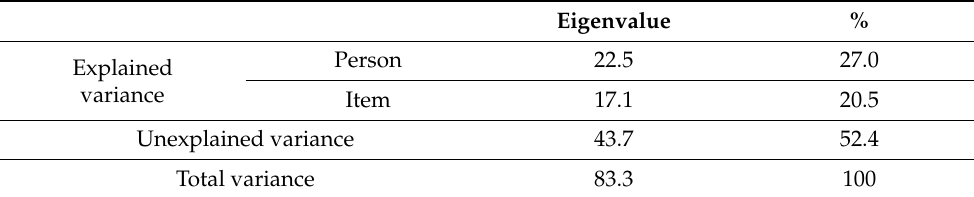
Table 6. Verification of Unidimensionality.